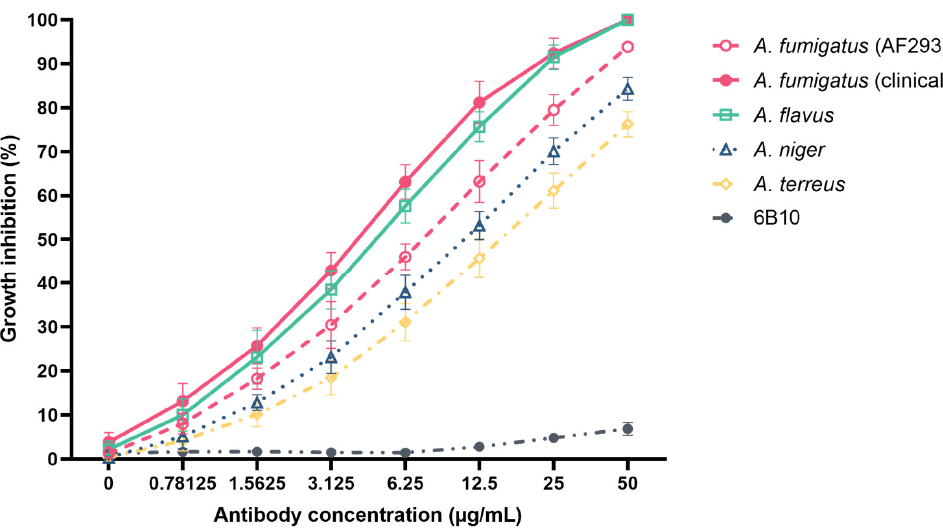
Figure 2. In vitro growth inhibition activity of mAb 1D2 with various concentrations against A. fumigatus , A. flavus , A. niger and A. terreus . Compared to the control mAb 6B10, mAb 1D2 showed significant growth inhibition on A. fumigatus (two clinical strains), A. flavus and A. fumigatus (AF 293), followed by A. niger and A. terreus . With the increase in antibody concentration, the growth inhibition effect of 1D2 steadily